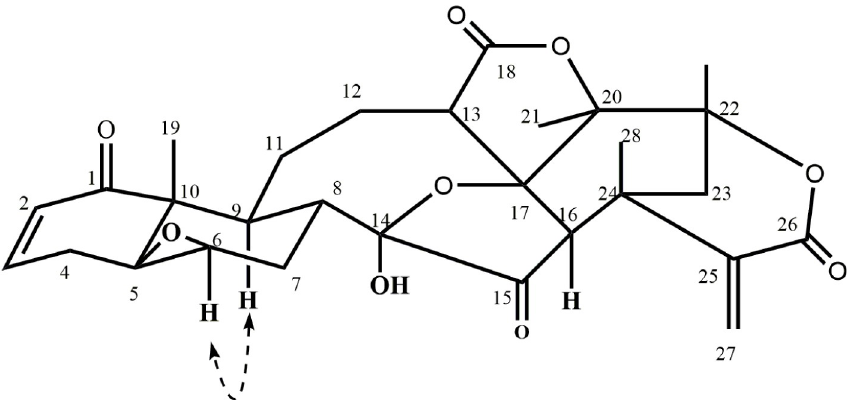
Fig 5. Key NOESY correlations in compounds